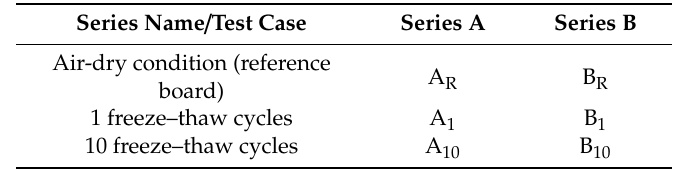
Table 2. Series of fibre-cement boards and test cases and their denotations.